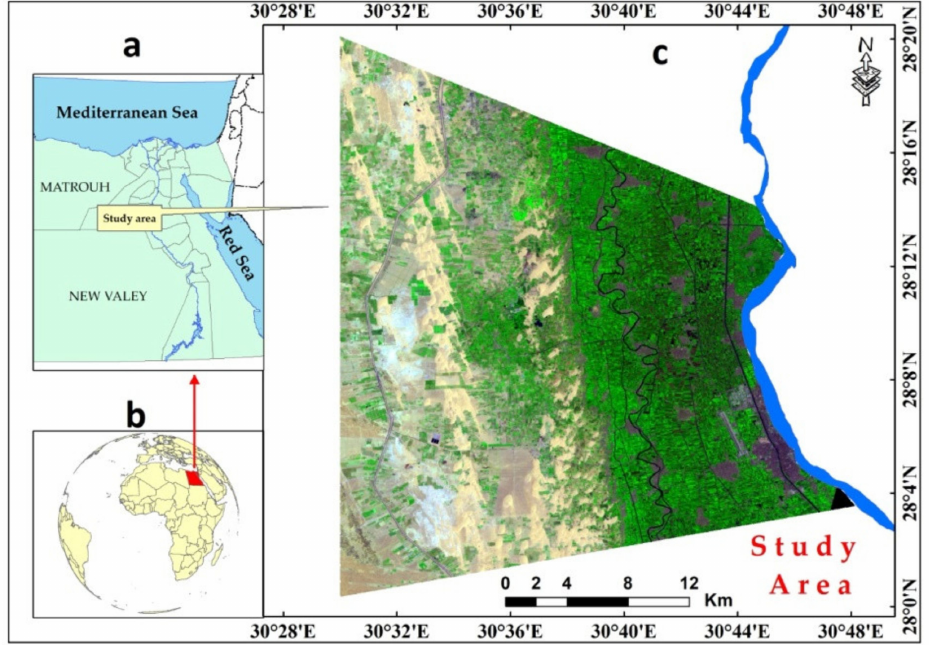
Figure 1. ( a ) Location of Egypt on the world map, ( b ) map of Egypt ( c ) location of area under investigation ( b